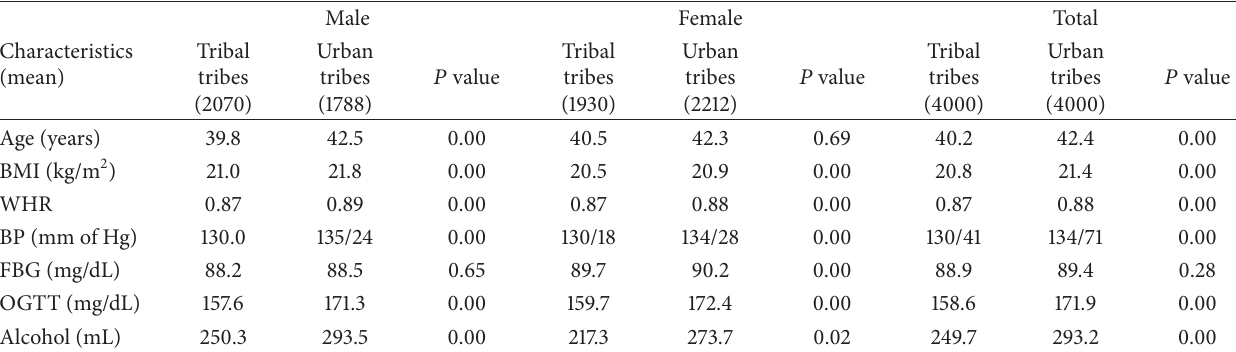
Table 3: Gender distribution of mean levels of anthropometry, blood glucose, and alcohol consumption among tribes of urban and tribal areas, Himachal Pradesh, 2011-2012.